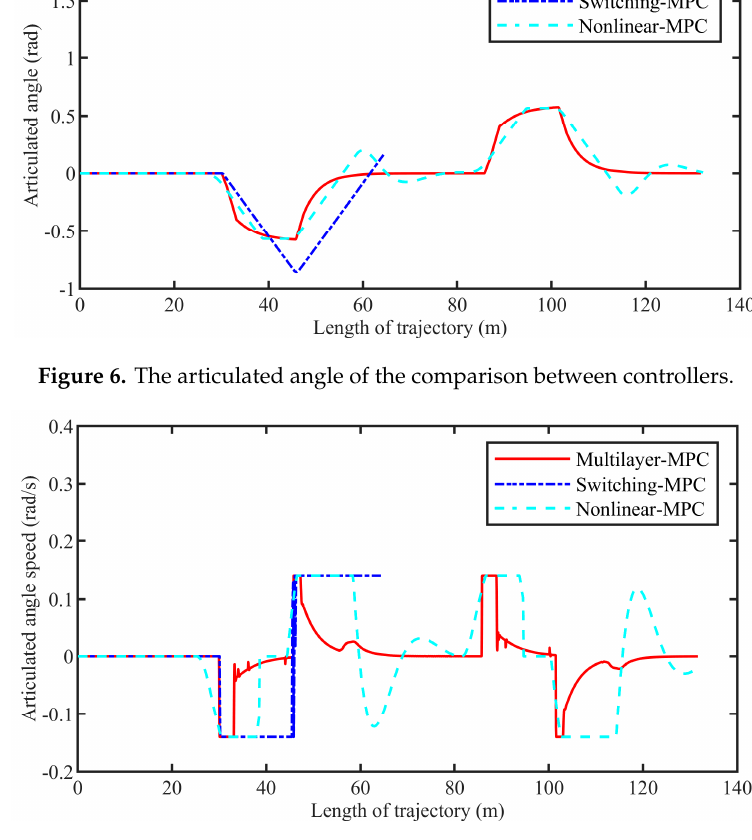
Figure 7. Articulated angle speed of the comparison between controllers. Table 2. Maximum